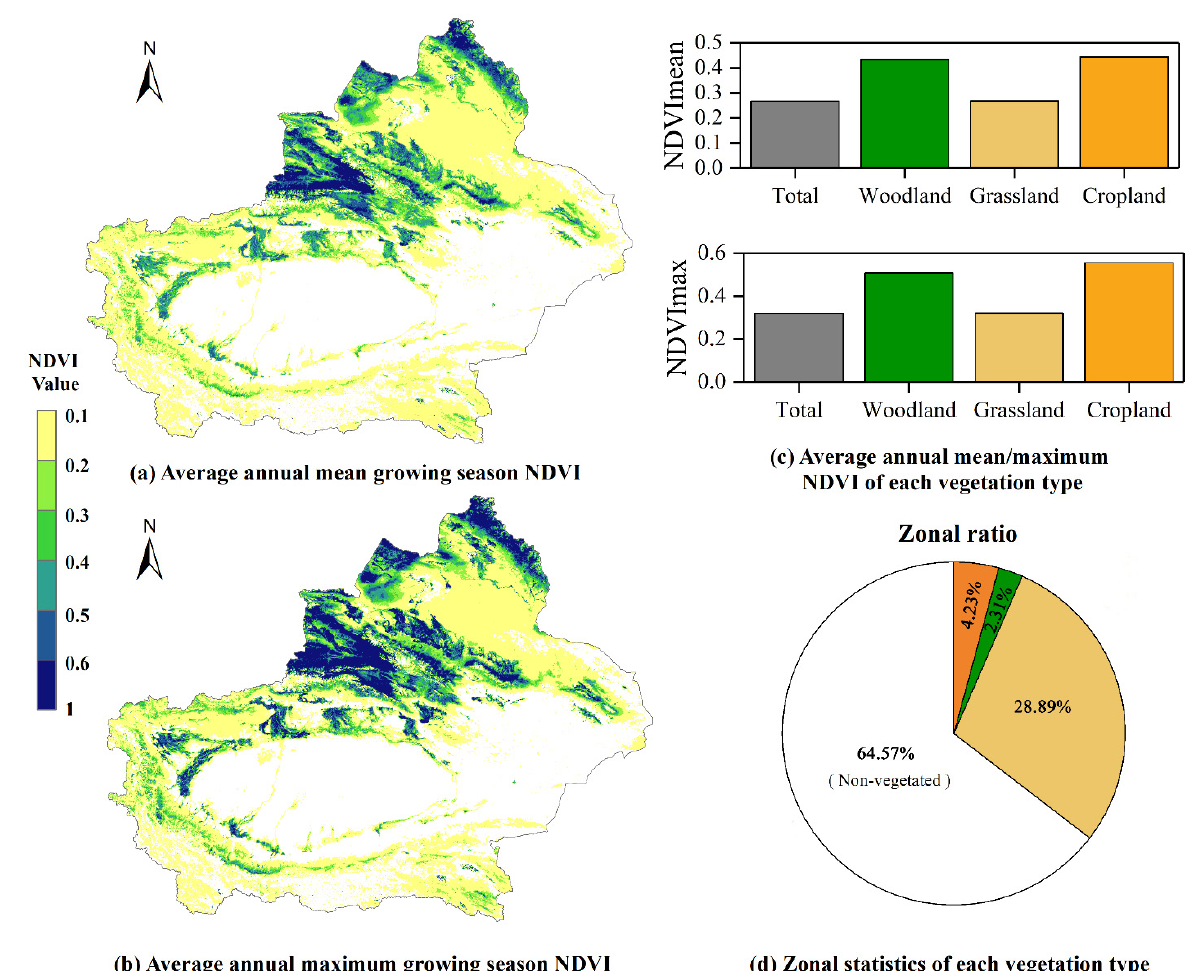
Figure 2. Spatial patterns of the long-term average growing season NDVI for 2000 − 2019, ( a ) mean NDVI (NDVI mean ), ( b ) maximum NDVI (NDVI max ). The white parts indicate the areas where the multiyear NDVI mean is under 0.1. ( c ) Average annual NDVI mean and NDVI max of each land use type for 2000–2019. The NDVI was calculated for the growing season from May to September. ( d ) Zonal statistics for each land use type were based on the land use map.